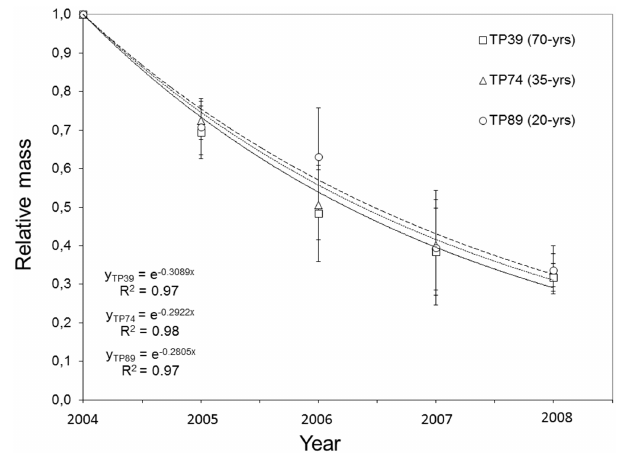
Figure 2. Needle litterfall, decomposition and net accumulation on the forest floor over 4 years (2004–2008) at the three older Turkey Point pine forest sites: TP89, TP74 and